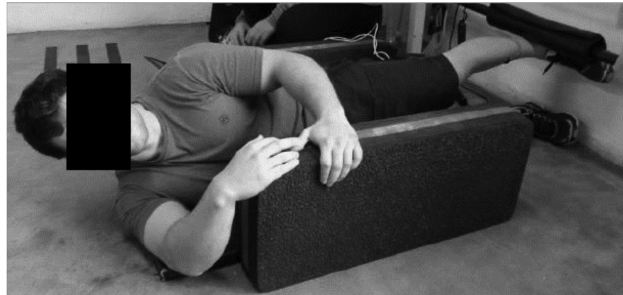
Figure 2. Isometric maximal voluntary contraction (iMVC) for hip abductors. Maximal test was performed with hip at 10º of